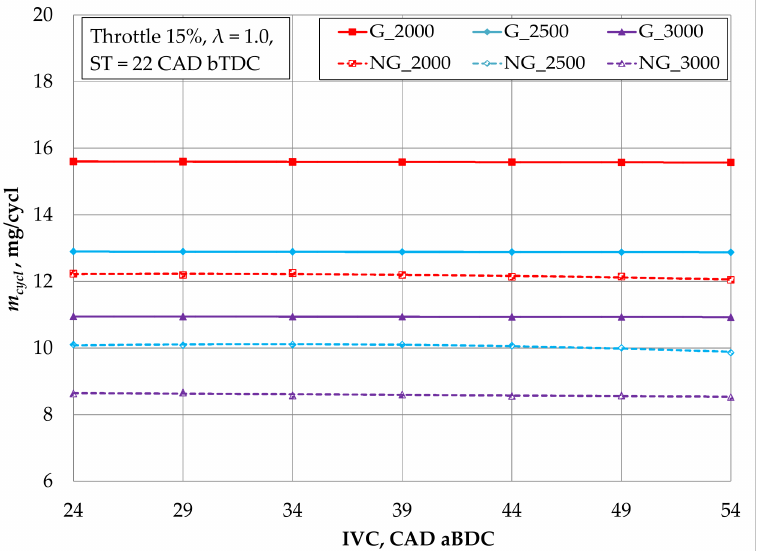
Figure 3. Fuel mass entering the cylinder over the cycle with gasoline and natural gas and while changing the intake valve close timing.